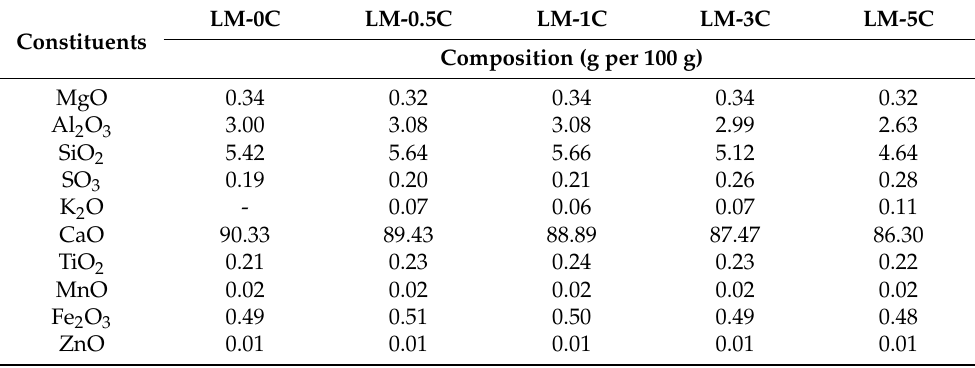
Table 2. Chemical composition of tested paste mixtures.